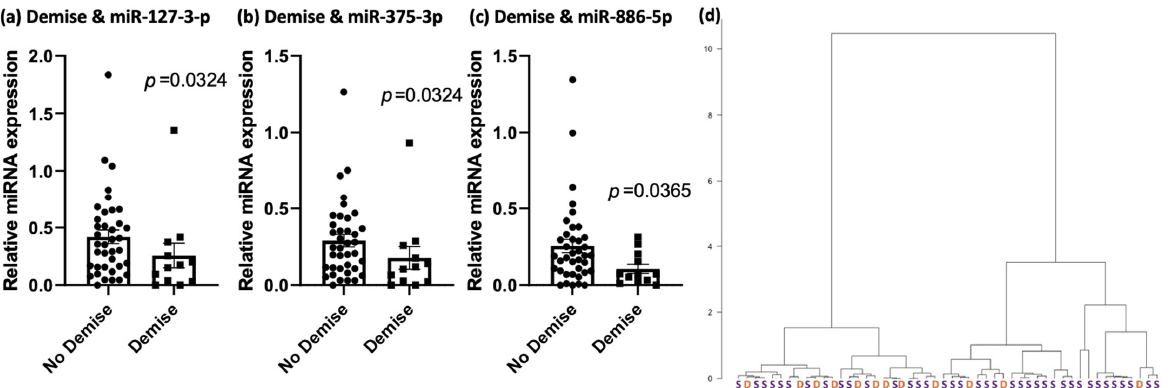
Figure 4. ( a – c ) Bar graphs comparing relative expression of miRNA-127-3p ( p = 0.0324), miRNA-375-3p ( p = 0.0324) and miRNA-886-5p ( p = 0.0365) between TTTS fetuses with demise versus survival to delivery (no demise). ( d ) Hierarchal cluster demonstrating the sorting of TTTS subjects by demise status (demise shown as orange ‘D’, survival as purple